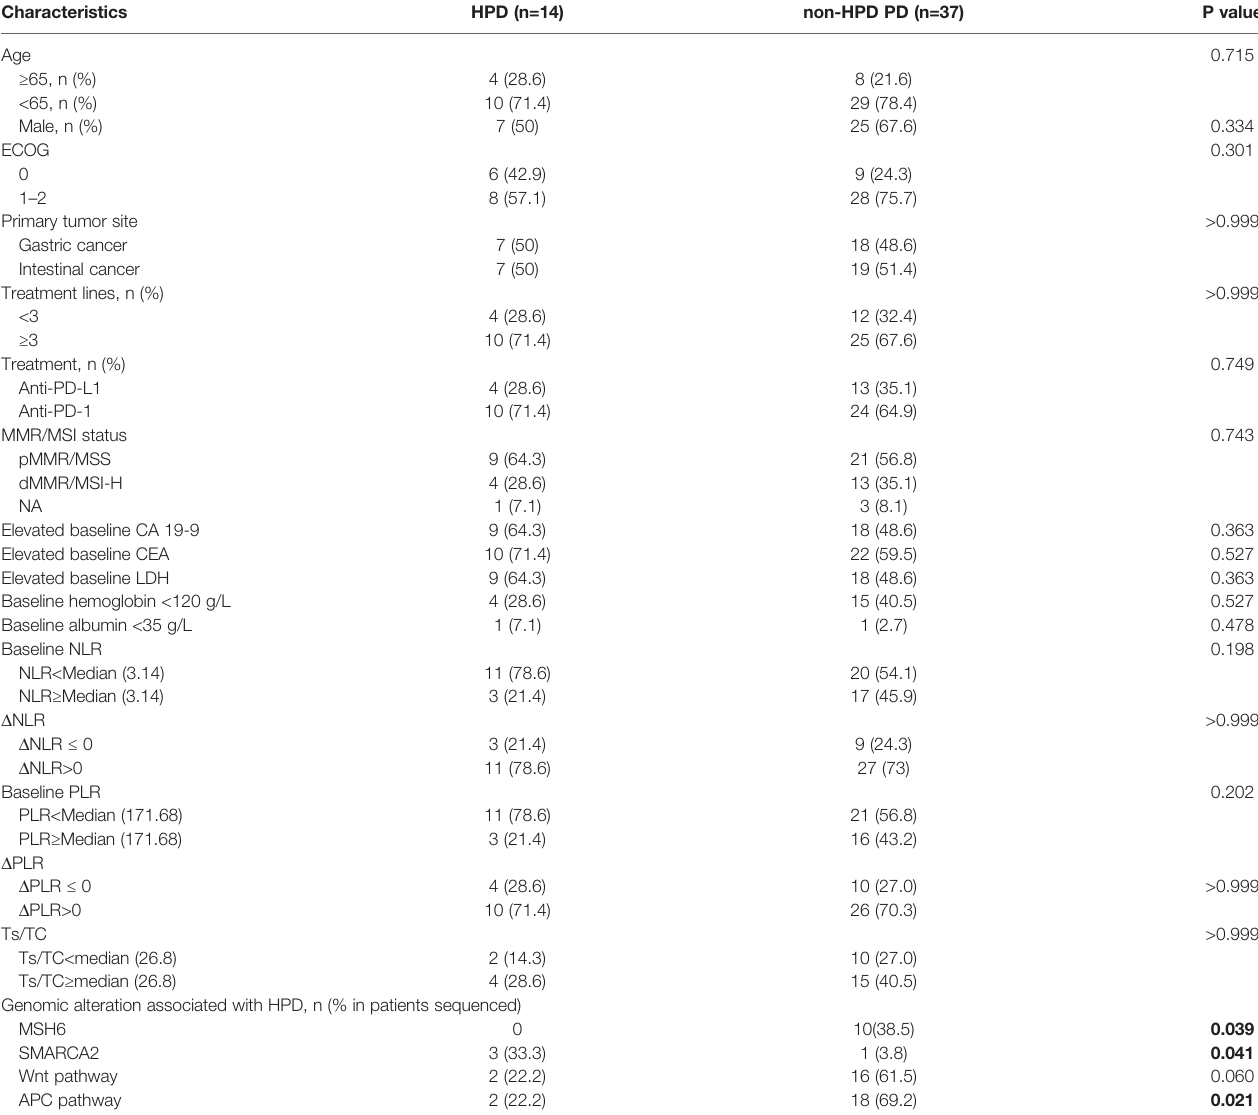
TABLE 4 | Clinical factors and genomic alterations associated with